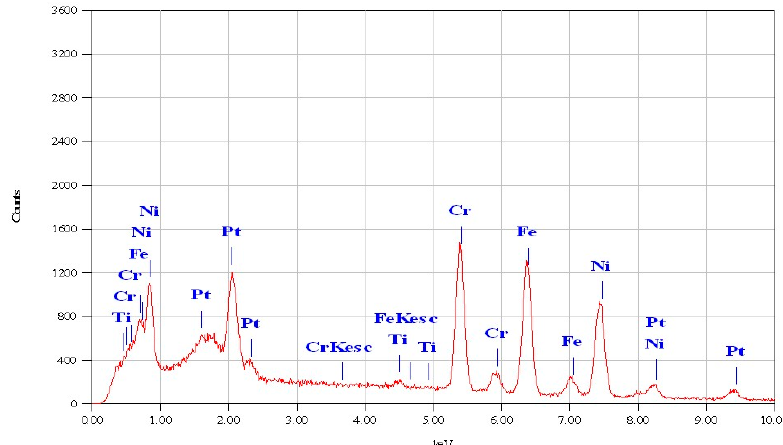
Figure 5. EDS pattern of Incoloy 825 alloy layer from Figure 4. Table 3. Chemical composition of Incoloy 825 alloy layer.